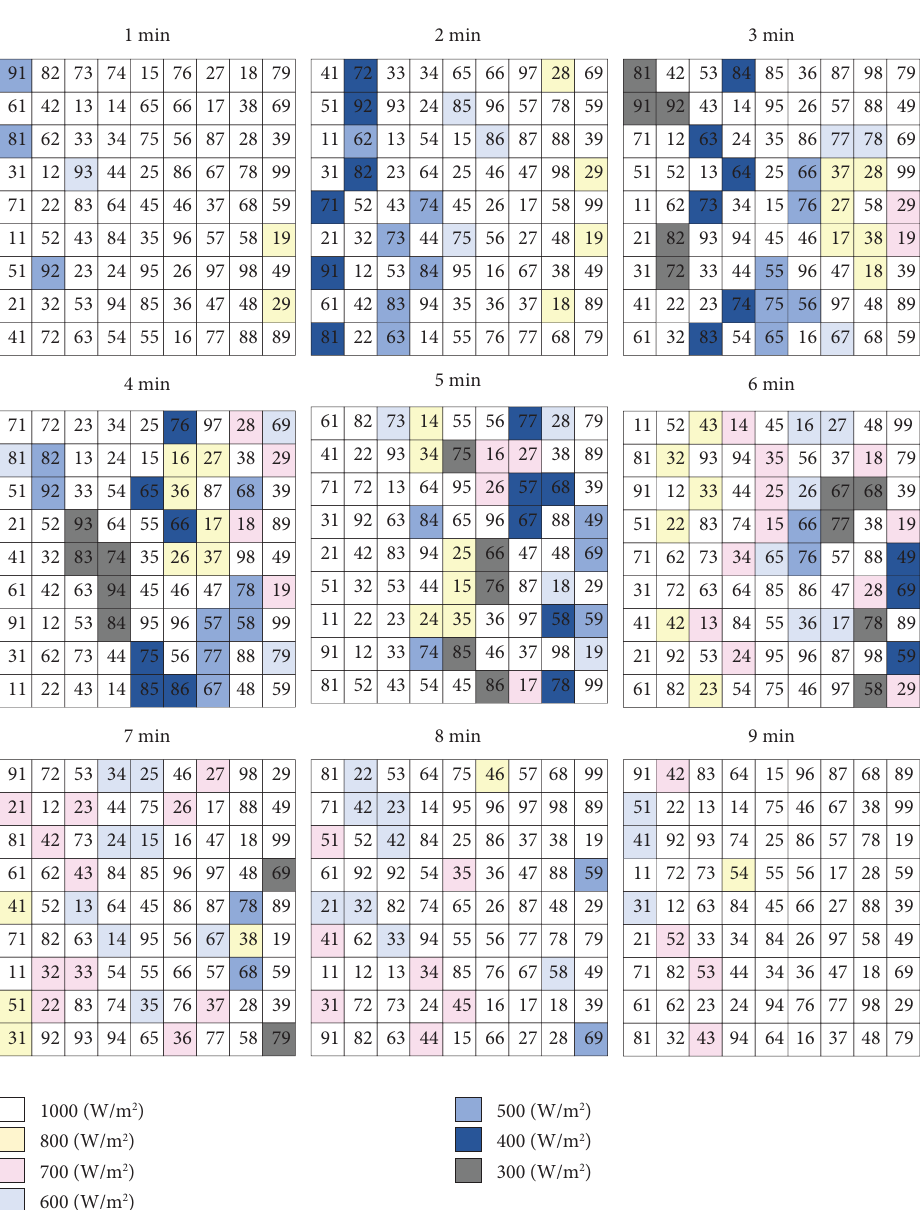
Figure 6: Optimal irradiation scheme of PV arrays by ASO in 9 minutes under the shadow of moving